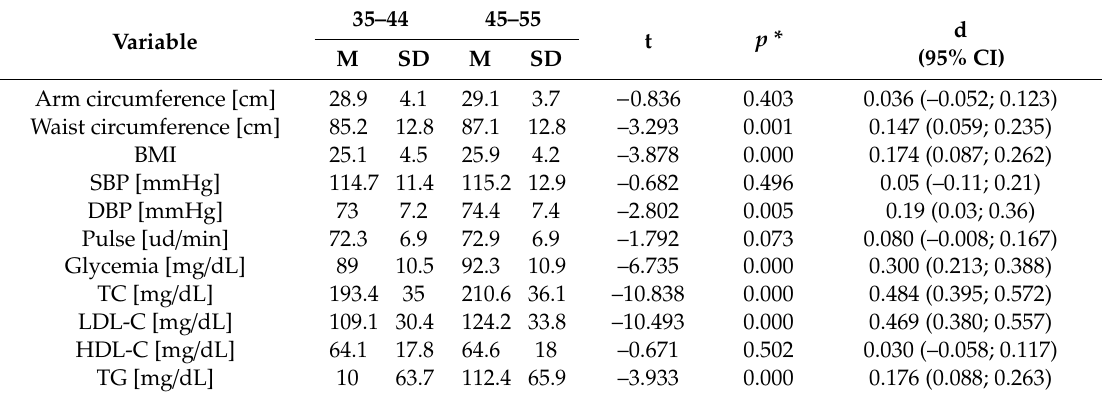
Table 5. The mean values of selected parameters with regard to age